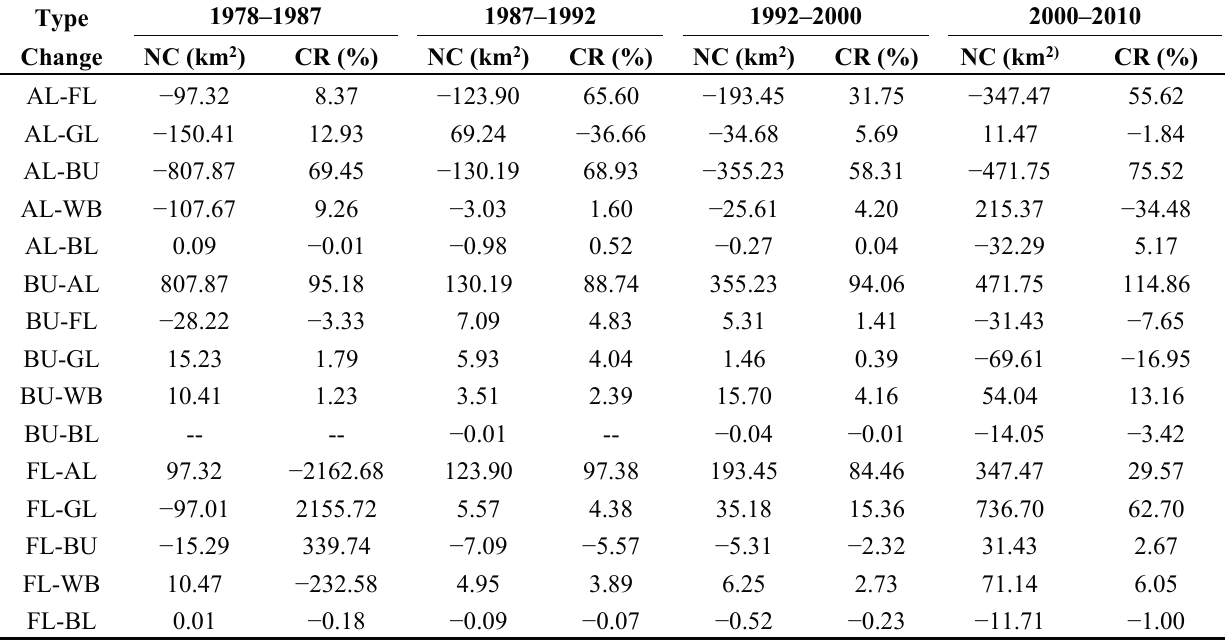
Table 7. Conversion and its contribution rate for arable land, built-up area and forest land with other land use types in different